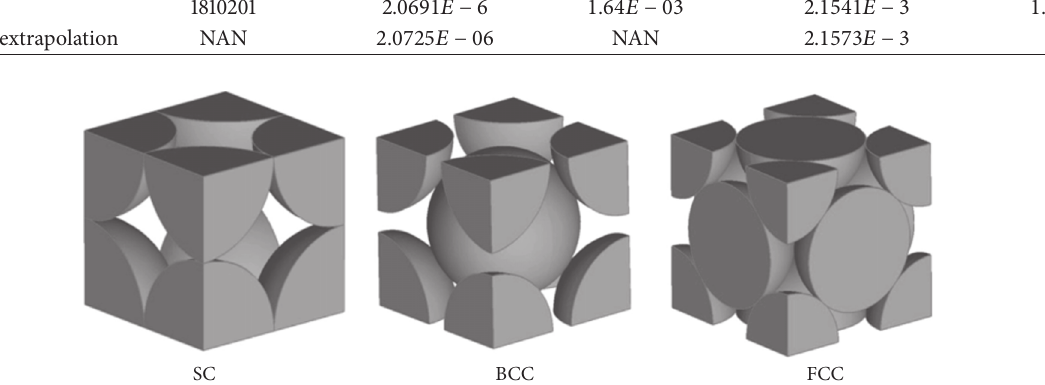
Figure 2: Structured packed cells of spheres.